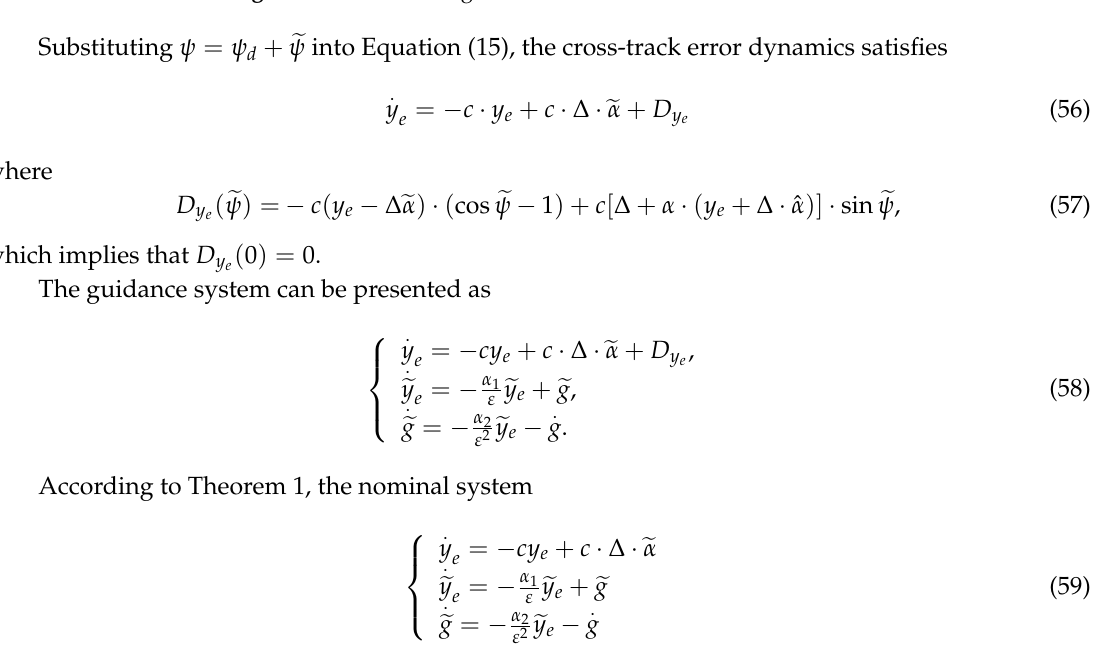
Figure 3. The block diagram of the HGESO-ASMPFC scheme.